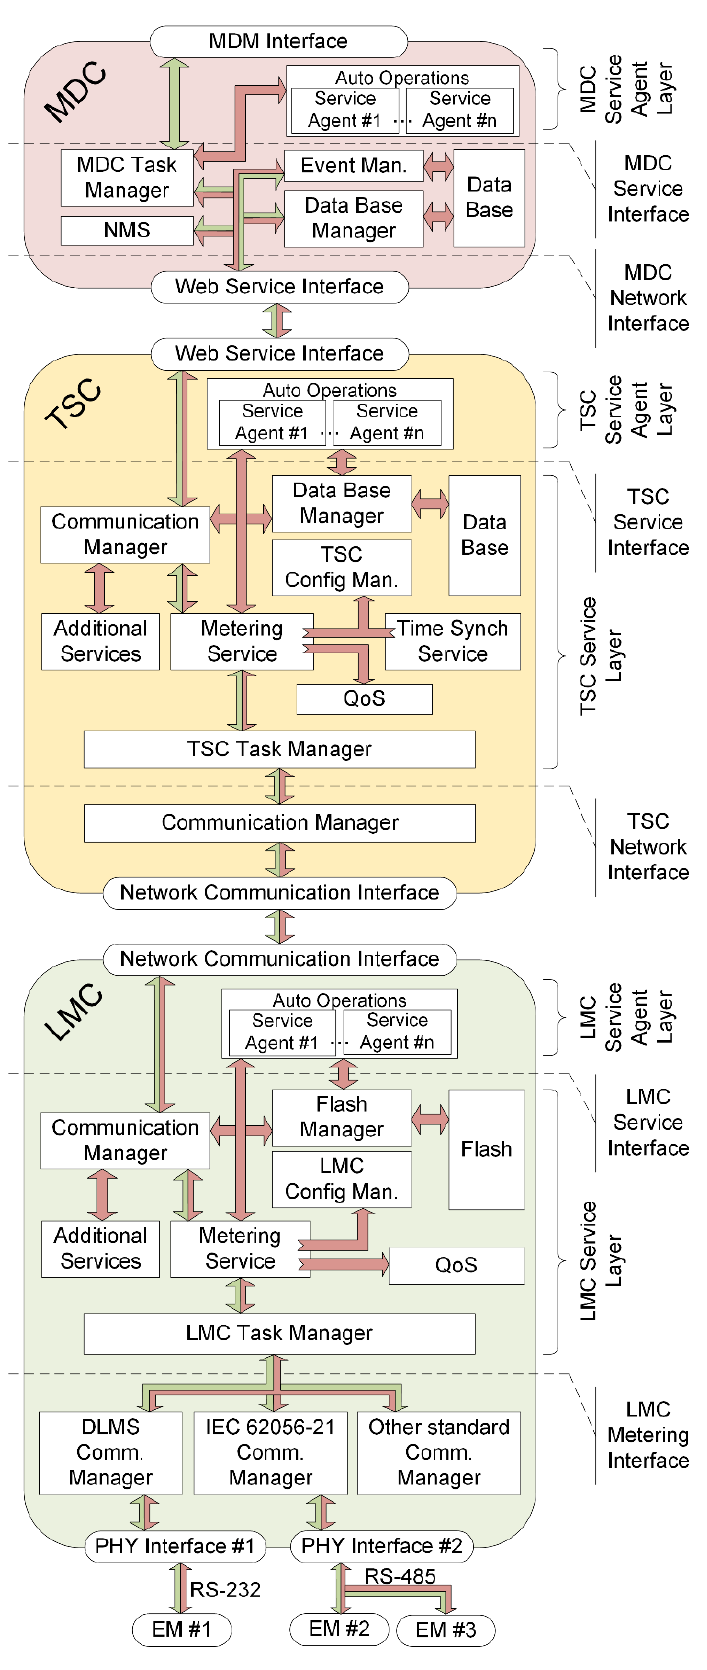
Figure 2. Deployment of AMI services with the details of command execution data flow (red arrows—automatic operations, green arrows—on-demand commands).